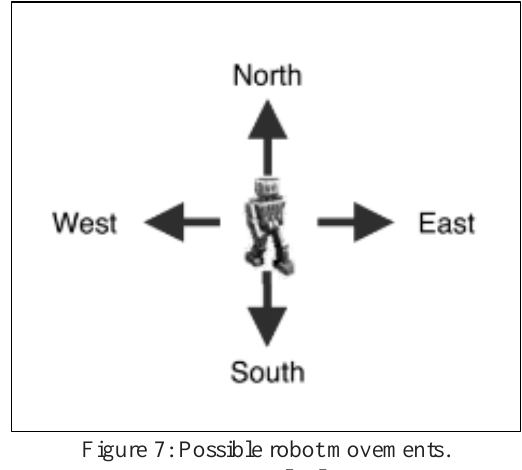
Figure 7: Possible robot movements.